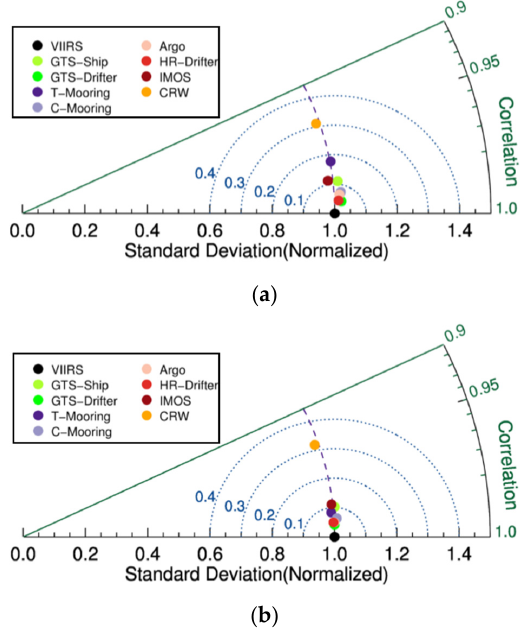
Figure 2. Comparisons between the NAVO S-NPP VIIRS SST and different types of in situ SST in Taylor diagram: ( a ) daytime; and ( b ) nighttime. Blue dot lines represent the normalized centered RMS error.